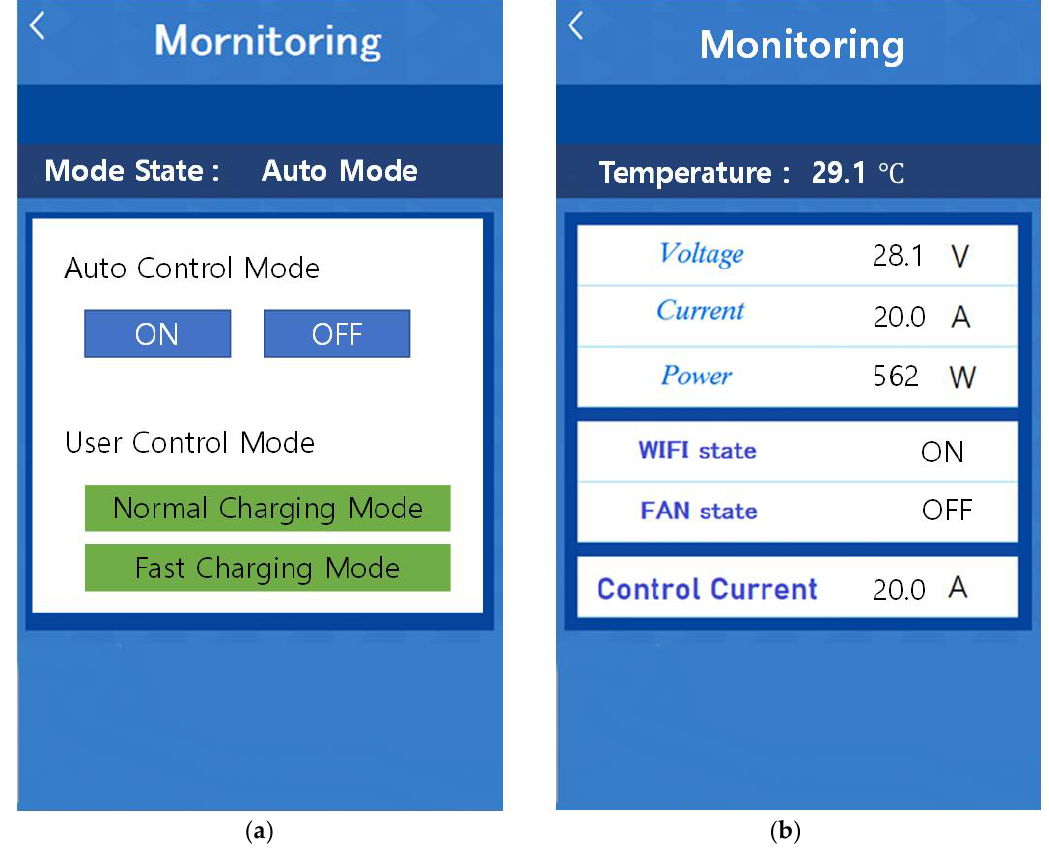
Figure 2. Smartphone application interface: ( a ) First interface; ( b ) Second interface.